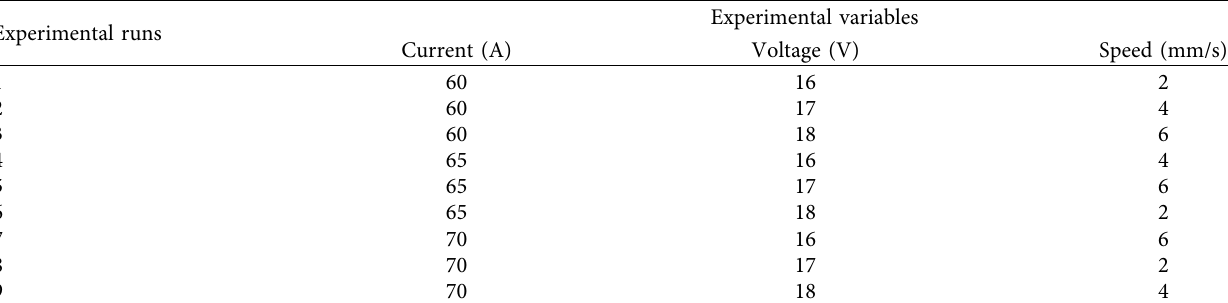
Table 4: Orthogonal arrays for number of